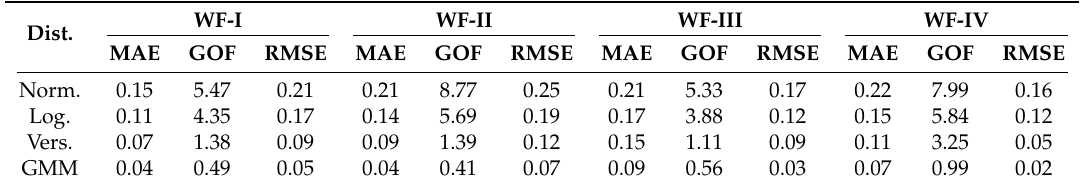
Table 4. Metrics of four distributions estimated for the CDF.